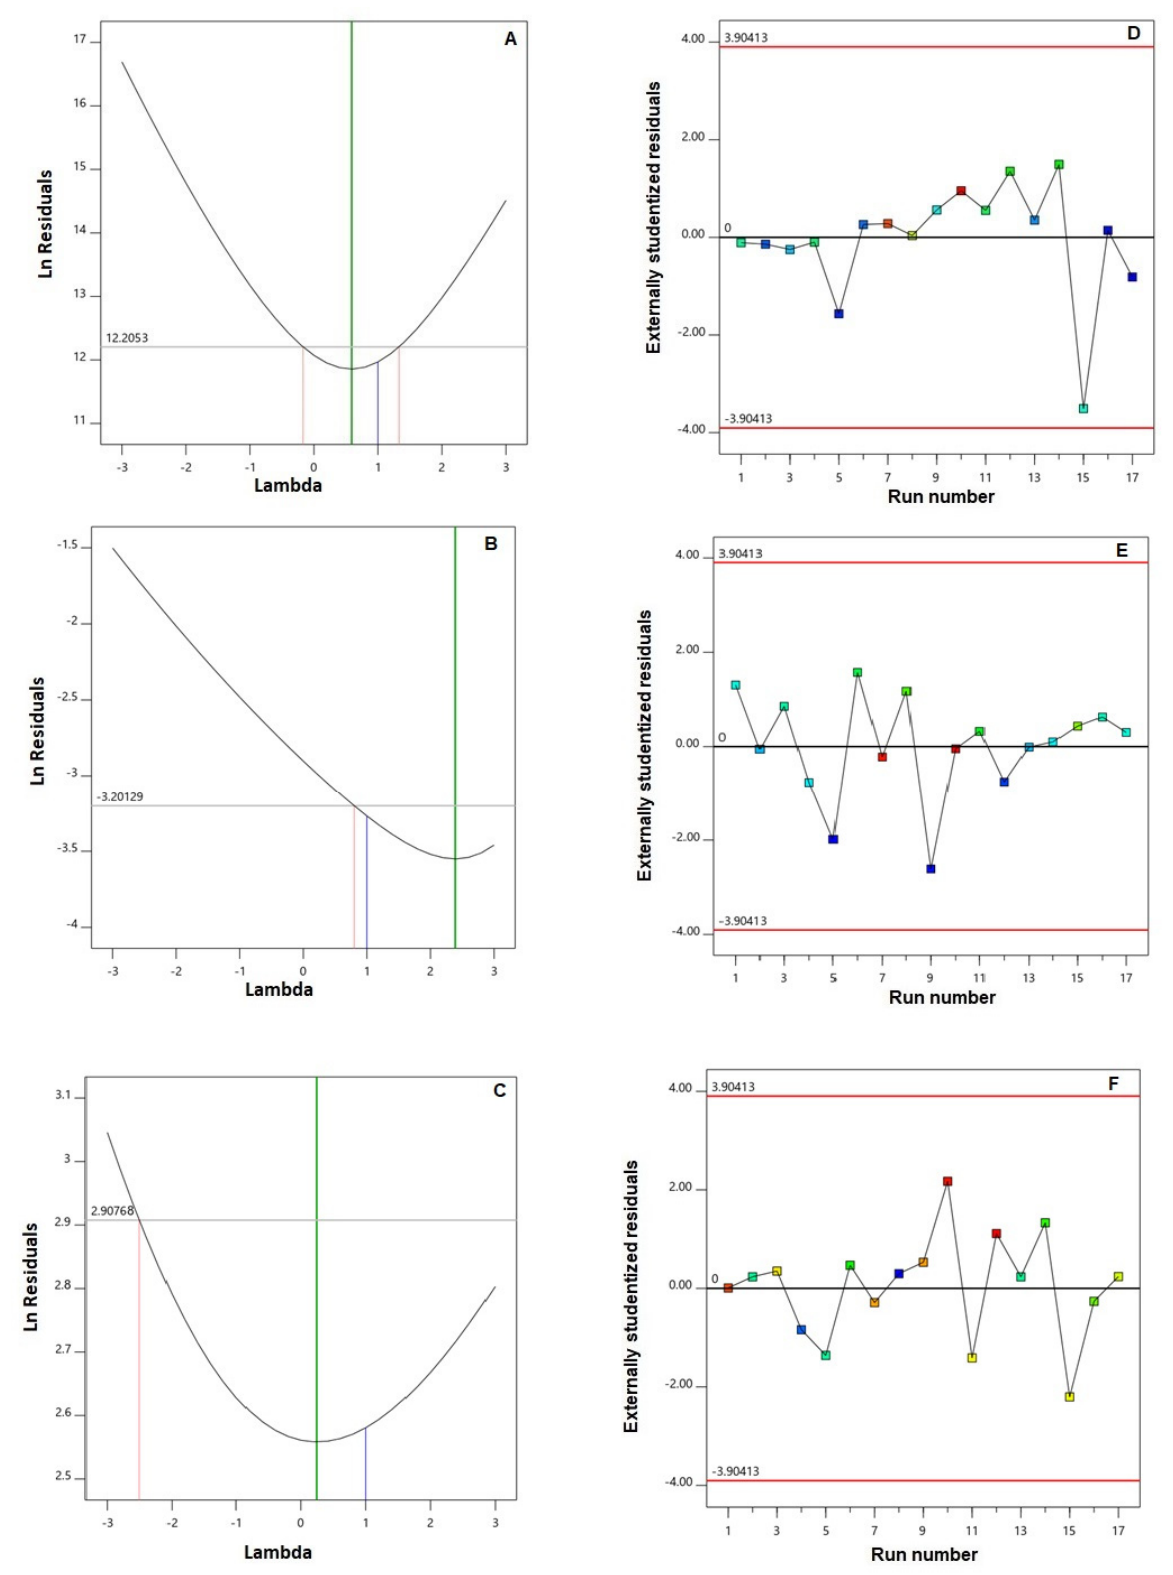
Figure 1. Diagnostic plots for the quadratic × linear model of the particle size ( A , D ), polydispersity index ( B , E ), and zeta potential ( C , F ) of SMV-SPNs (Box–Cox plot for power transforms ( A – C ); externally studentized residuals vs. run number plot and ( D – F )). Abbreviations: SMV, simvastatin; SPNs, spanlastics.